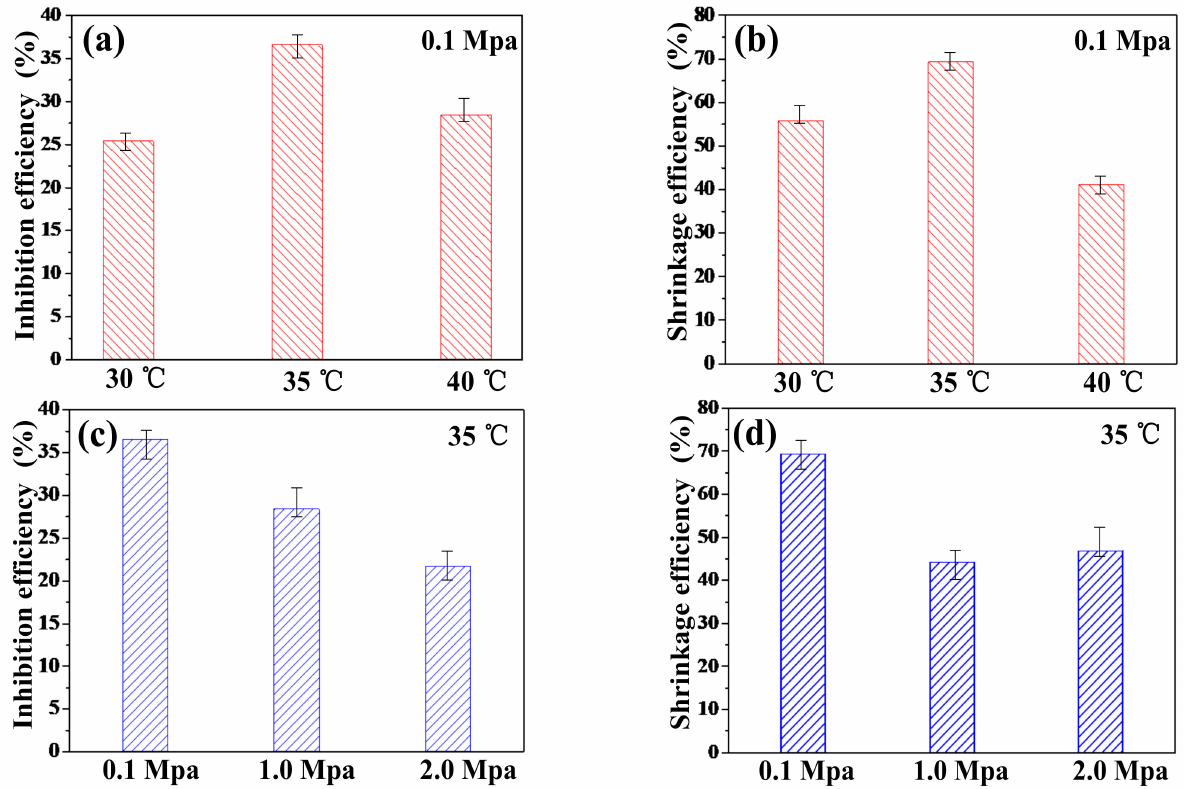
Figure 3. The inhibition efficiency and shrinkage efficiency of hydro-swelling by FeRM action at dif- ferent temperatures and pressures. ( a ) Inhibition efficiencies at different temperatures; ( b ) shrinkage efficiencies at different temperatures; ( c ) inhibition efficiencies at different pressures; ( d ) shrinkage efficiencies at different